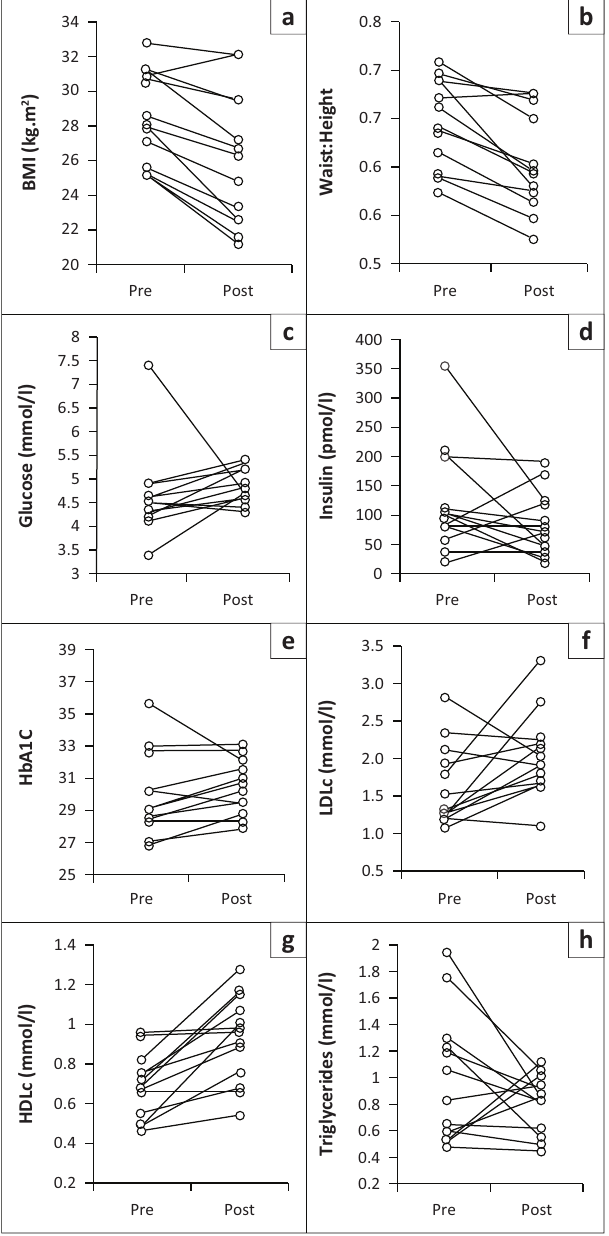
FIGURE 1: Individual responses for anthropometric and metabolic health outcome